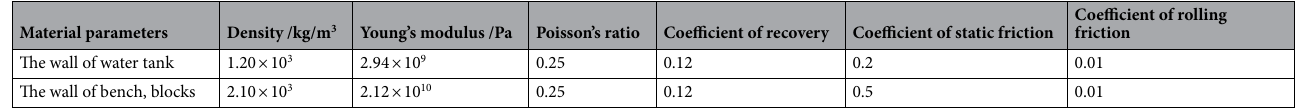
Table 2. Parameters of the EDEM model 29